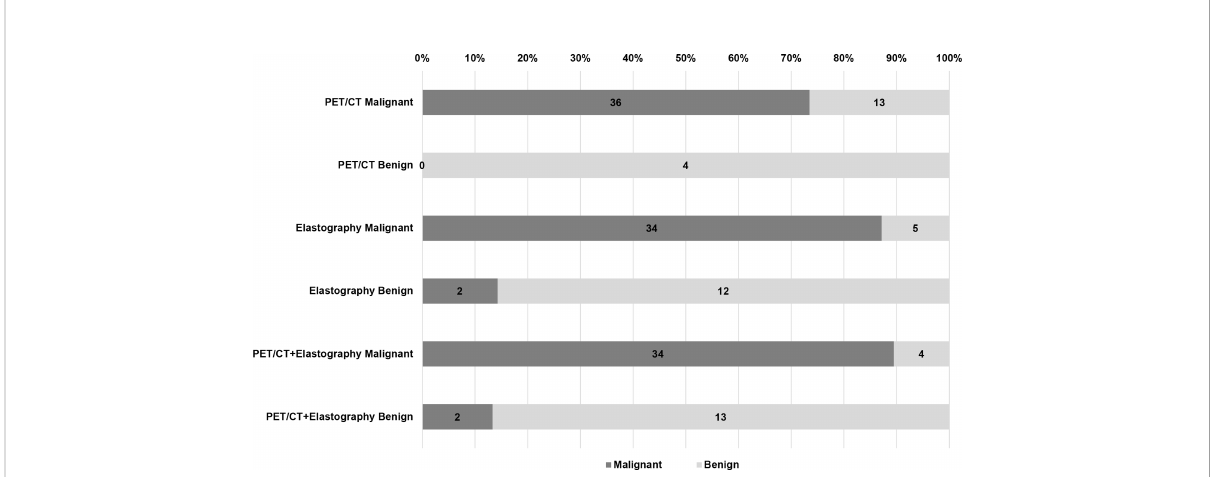
FIGURE 3 Diagnostic ef fi ciency of PET/CT, elastography, and combination method in the validation group. Of the 53 LNs in the validation group, there were 13 false positive and 0 false negative LNs in PET/CT, 5 false positive and 2 false negative LNs in elastography, but only 4 false positive and 2 false negative LNs in the combined method. LN, lymph